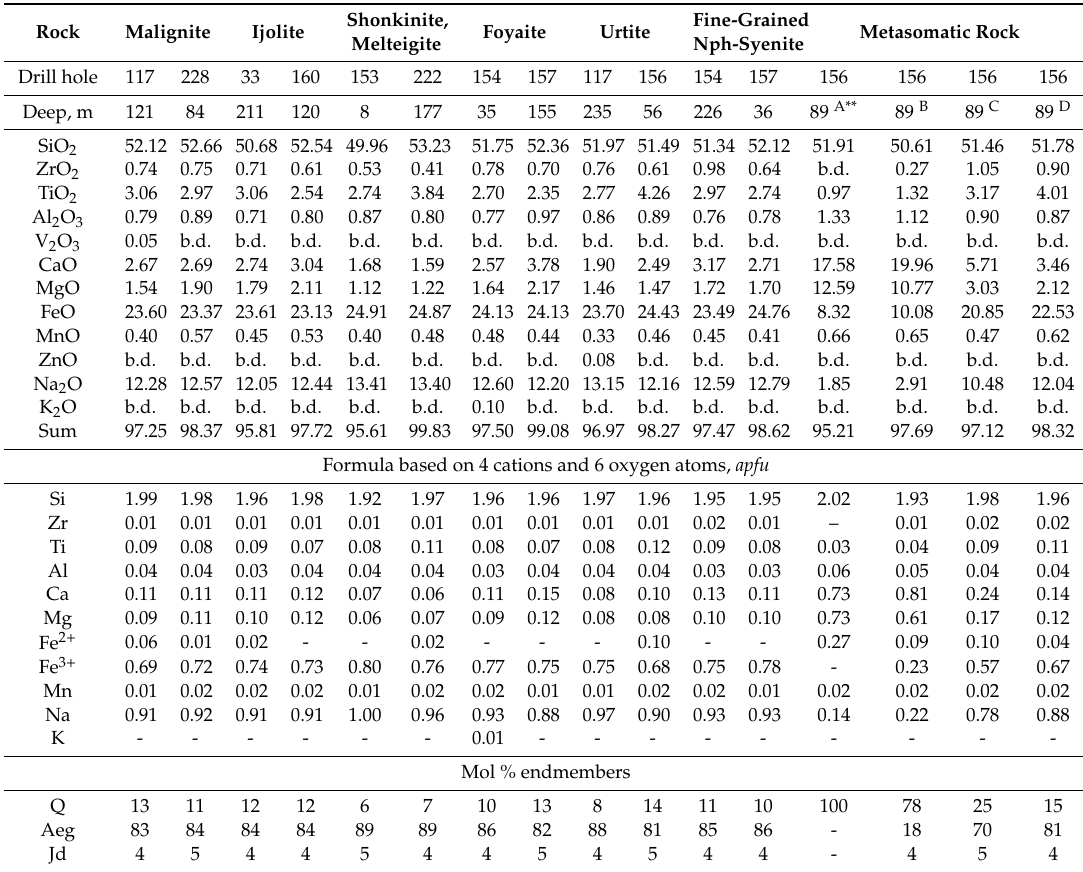
Table 3. Representative microprobe analyses of clinopyroxenes, wt.